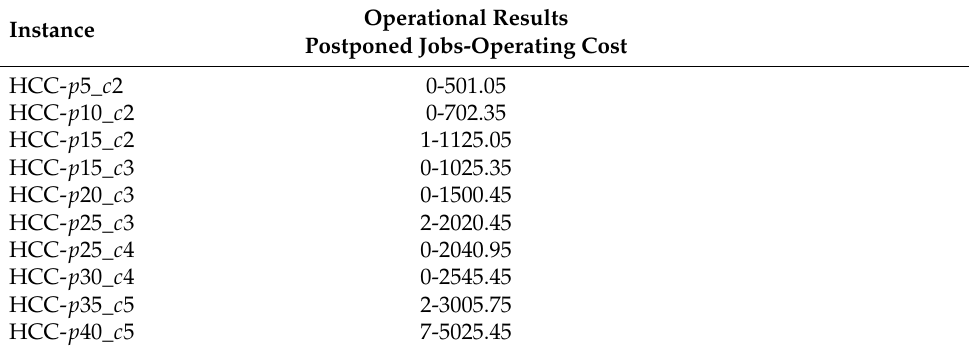
Table 5. Computational results.